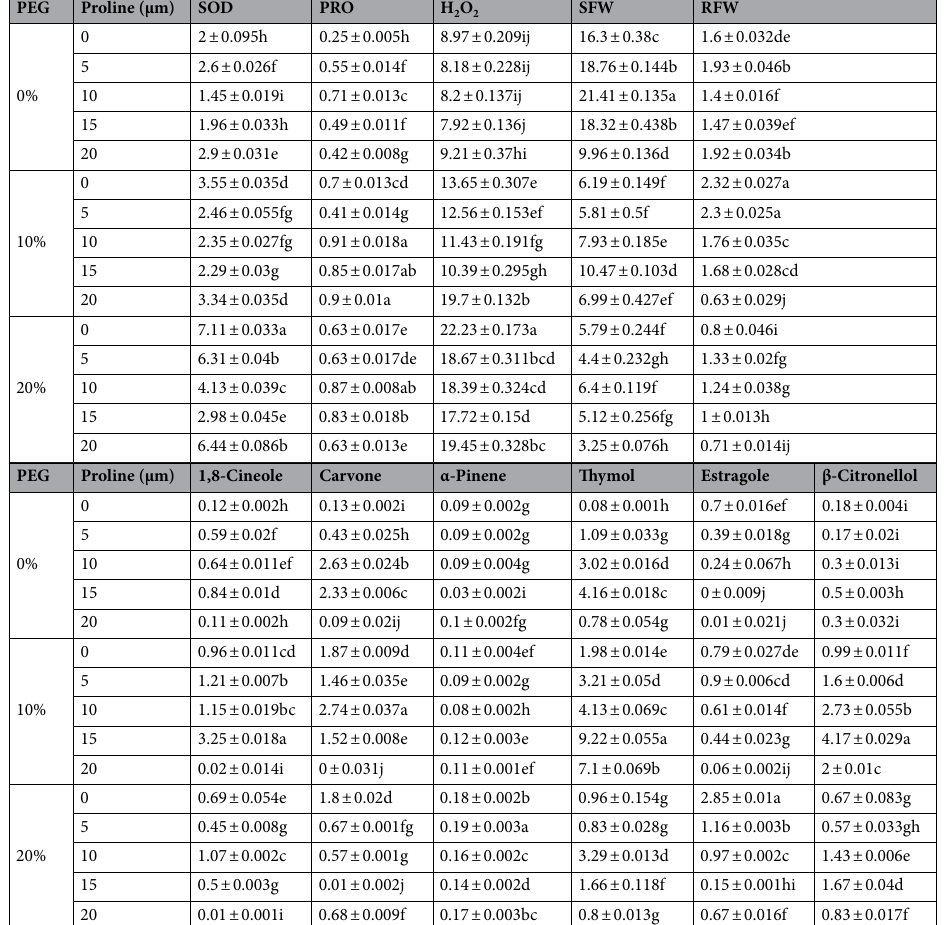
Table 1. Mean comparison of PEG by proline levels for the content of essential oils and other measured features in surahalala plants. Mean ± standard error of mean (based on 8 glass containers as replications). In each column, means with the same letter(s) are not significantly different (LSD